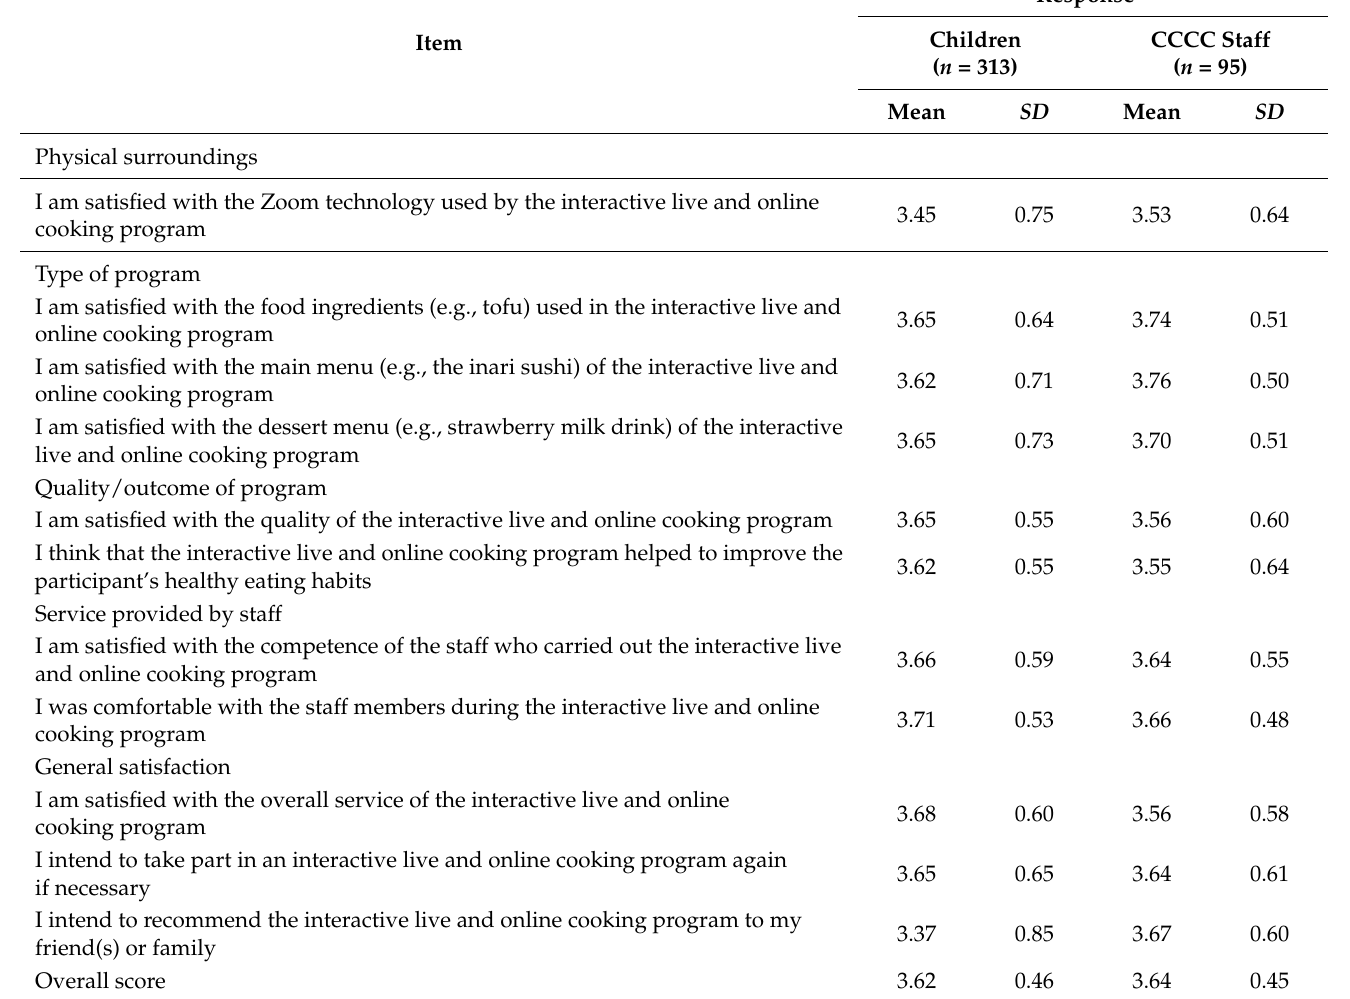
Table 2. Participant satisfaction with the program.